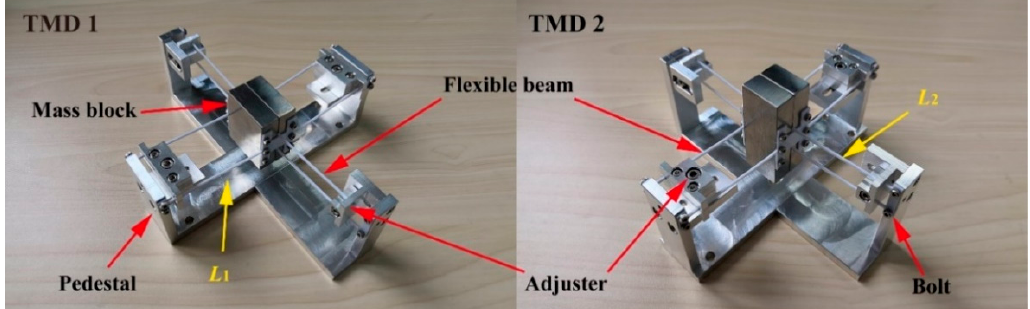
Figure 16. Prototype of the 2 DOFs TMDs.